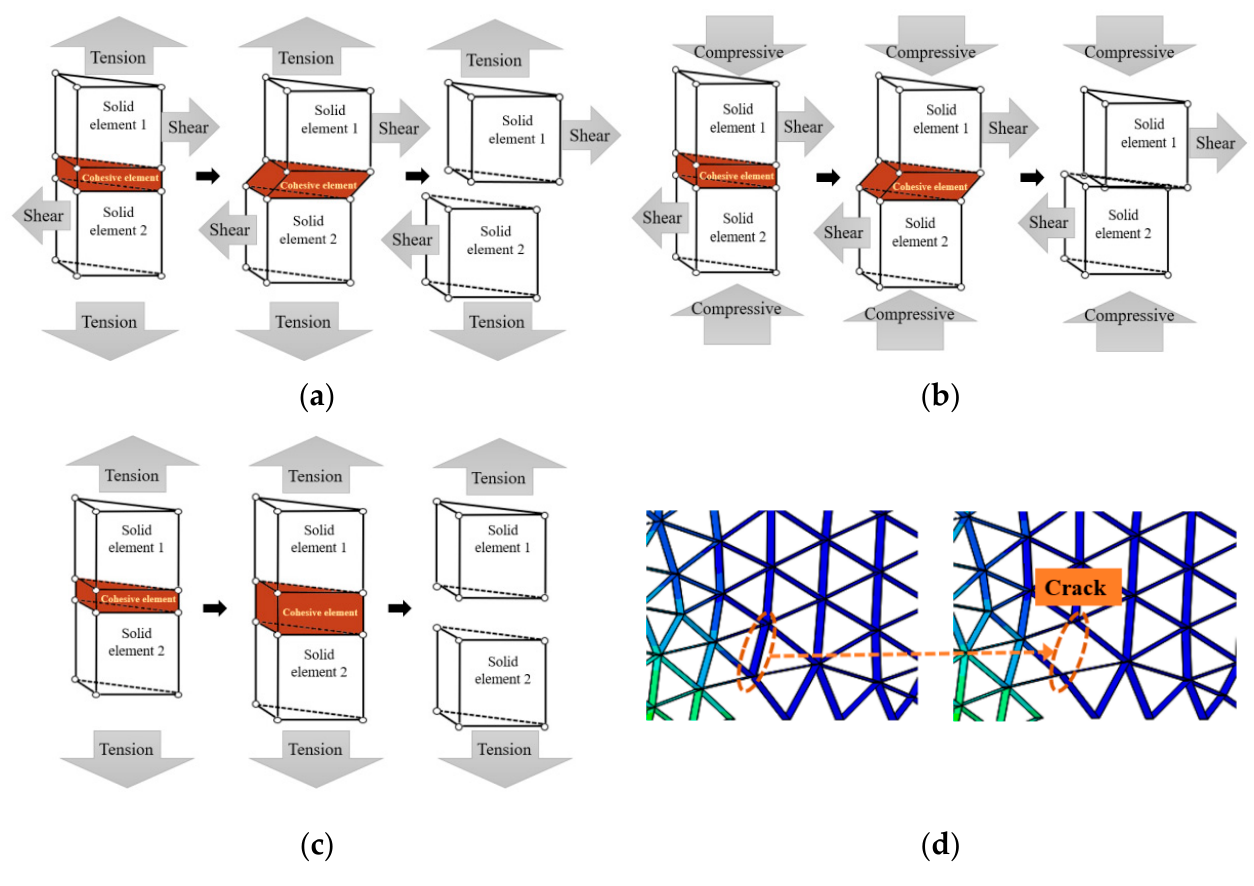
Figure 4. The schematic diagram of crack evolution: ( a ) schematic representation of tensile shear crack evolution; ( b ) schematic representation of compressive shear crack evolution; ( c ) tension crack evolution; and ( d ) failure of the removal of the cohesive element.